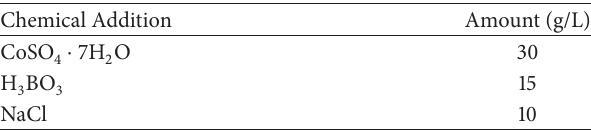
Table 1: Chemical composition of bath used for electrodeposition of nano Co-coated Ni sheet.